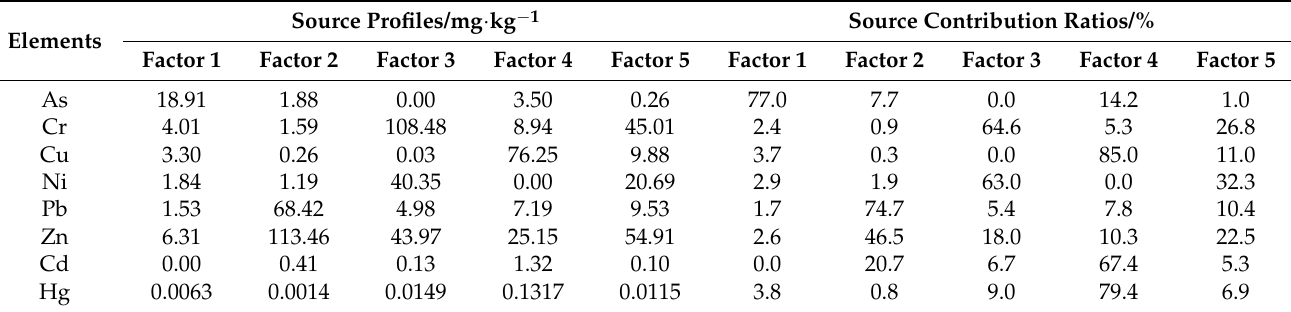
Table 4. Source profile and source contribution ratios for different heavy metals by